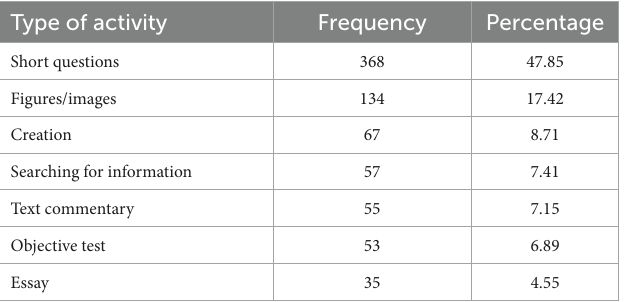
TABLE 9 Type of activities contained in textbooks (2nd year of secondary